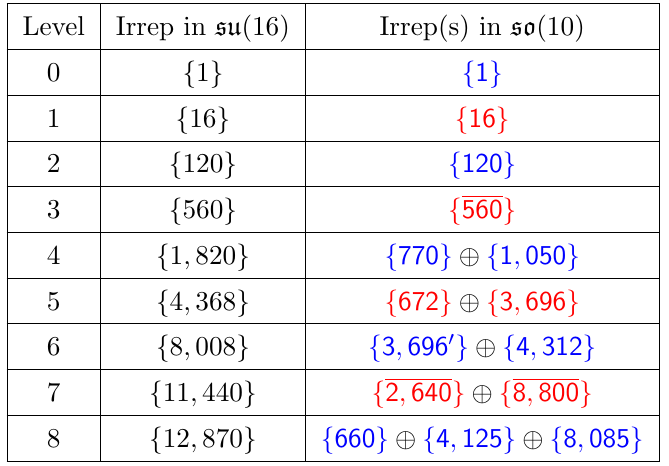
Table 5 . Summary of su (16) to so (10) branching rules for level-0 to 8 in 10D, N = 1 scalar